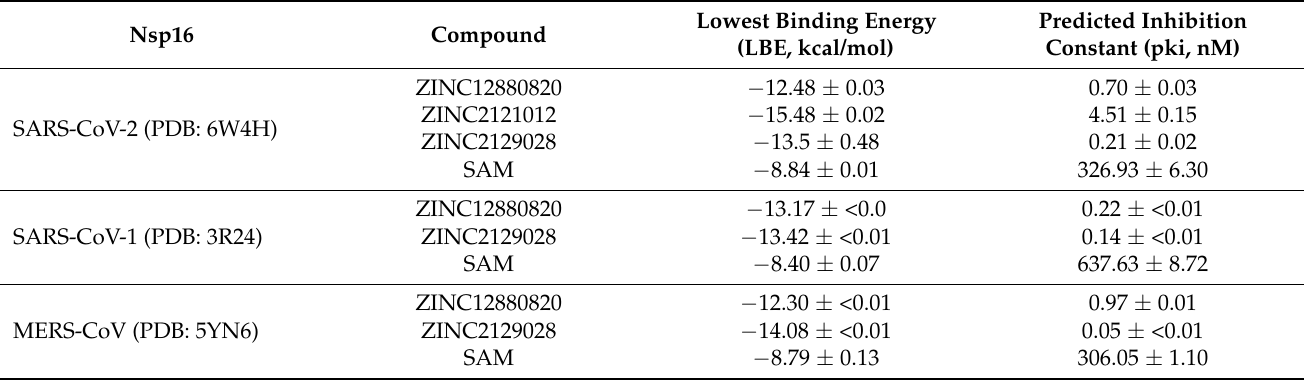
Table 3. Molecular docking of the hits and the control SAM against nsp16 of SARS-CoV-2, SARS- CoV-2, and MERS-CoV.